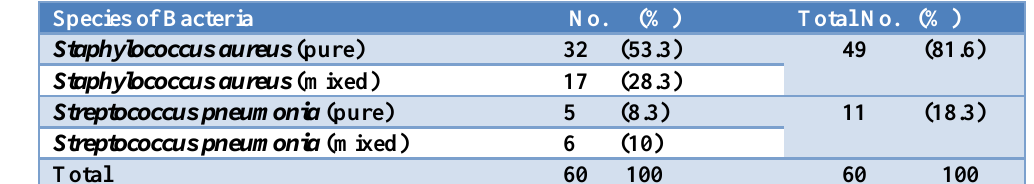
Table, 1: Total Isolates and Species of each bacterium isolated. Species of Bacteria Staphylococcus aureus (pure)